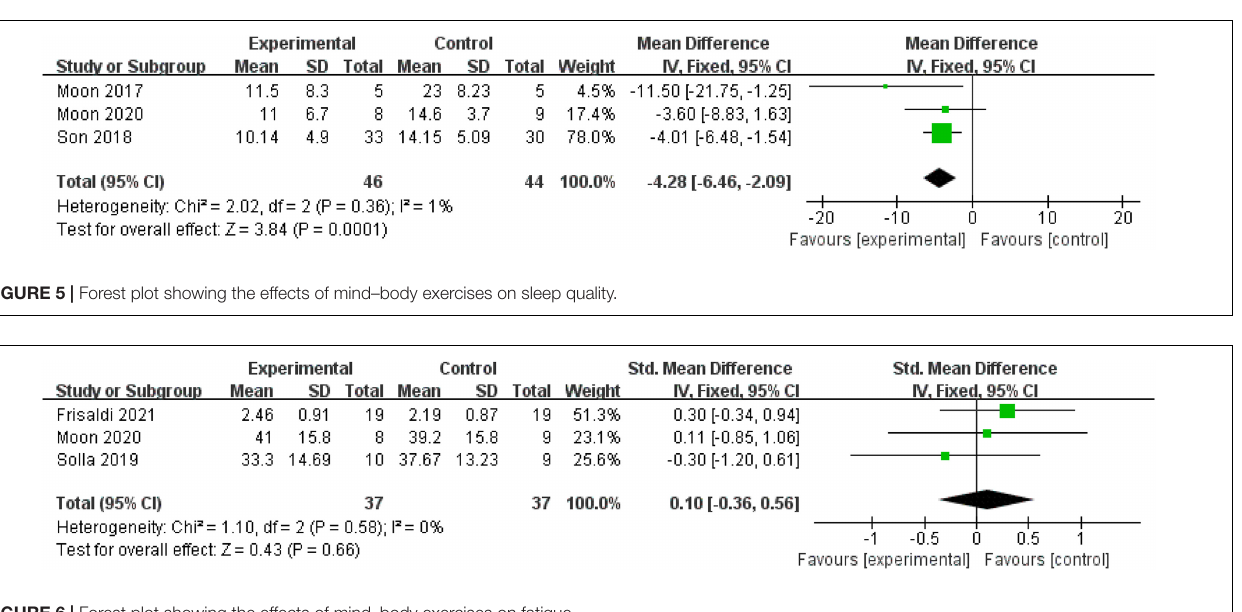
FIGURE 6 | Forest plot showing the effects of mind–body exercises on